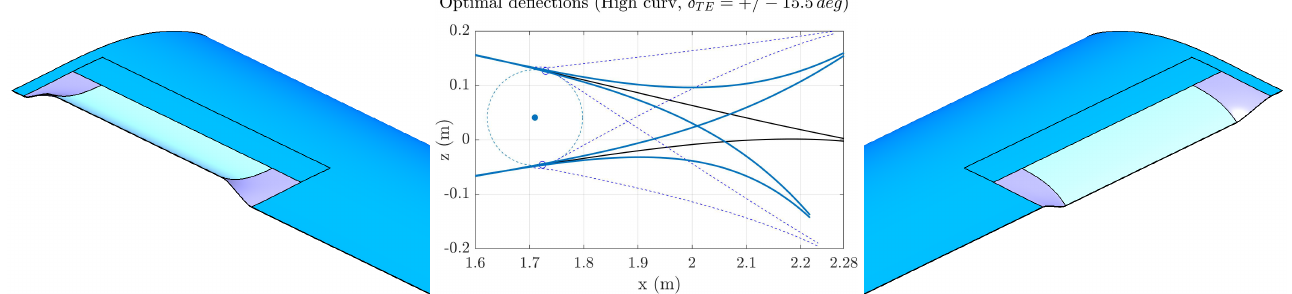
Figure 7. Optimal downward ( right half wing) and upward ( left half wing) morphing deflections and comparison with the maximum hinged aileron rotations.